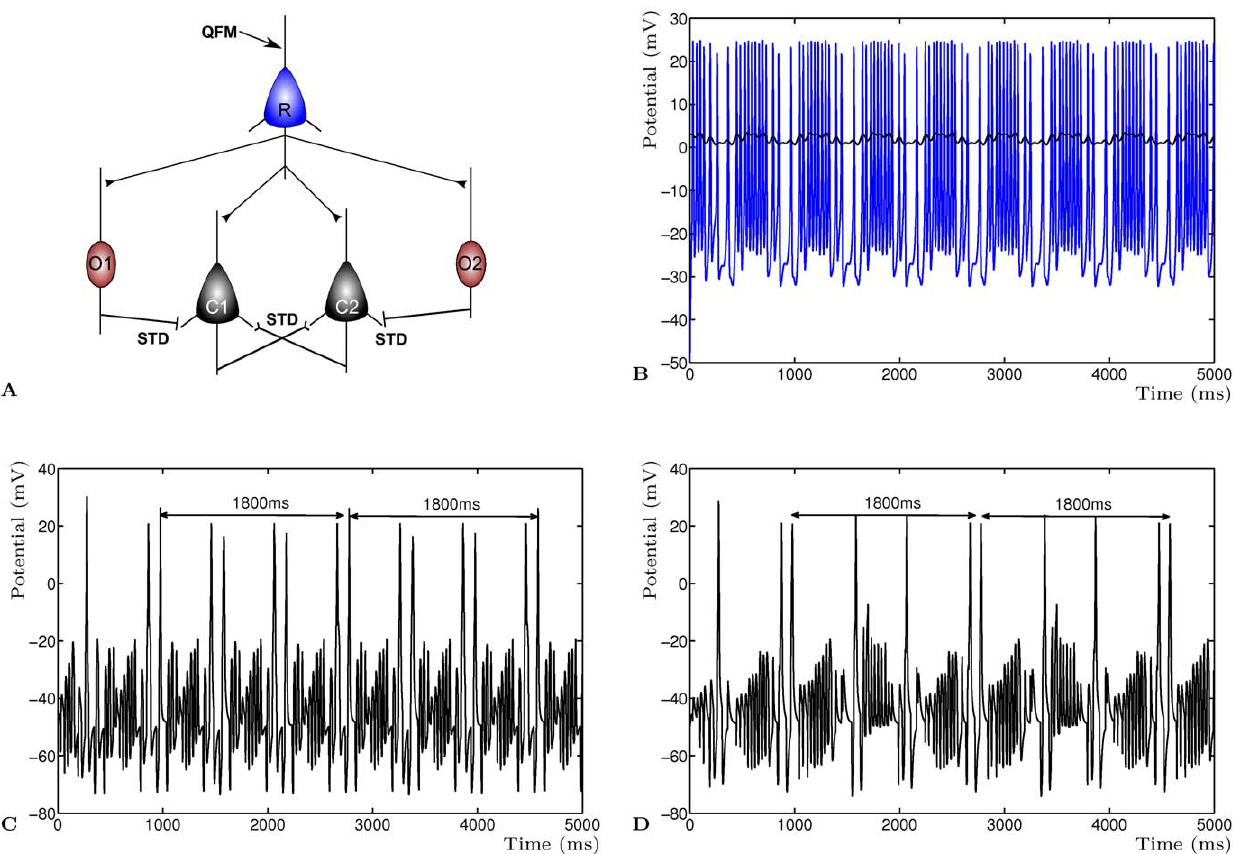
Figure 5. Frequency response model with Short Term Depression. The network neural activity is selected from existing frequencies in the compound input using characteristic activity of the onset neurons. A Scheme of a plausible microcircuit in the ventral cochlear nucleus. B Burst activity of the receptor neuron R with compound input QFM (black). C Chopper neuron C 1 activity resulting in an 1800 ms emergent frequency as part of its unique pattern due to the characteristic frequency of O 1 . D Chopper neuron C 2 activity with 1800 ms activity pattern and unique activity pattern due to O 2 .